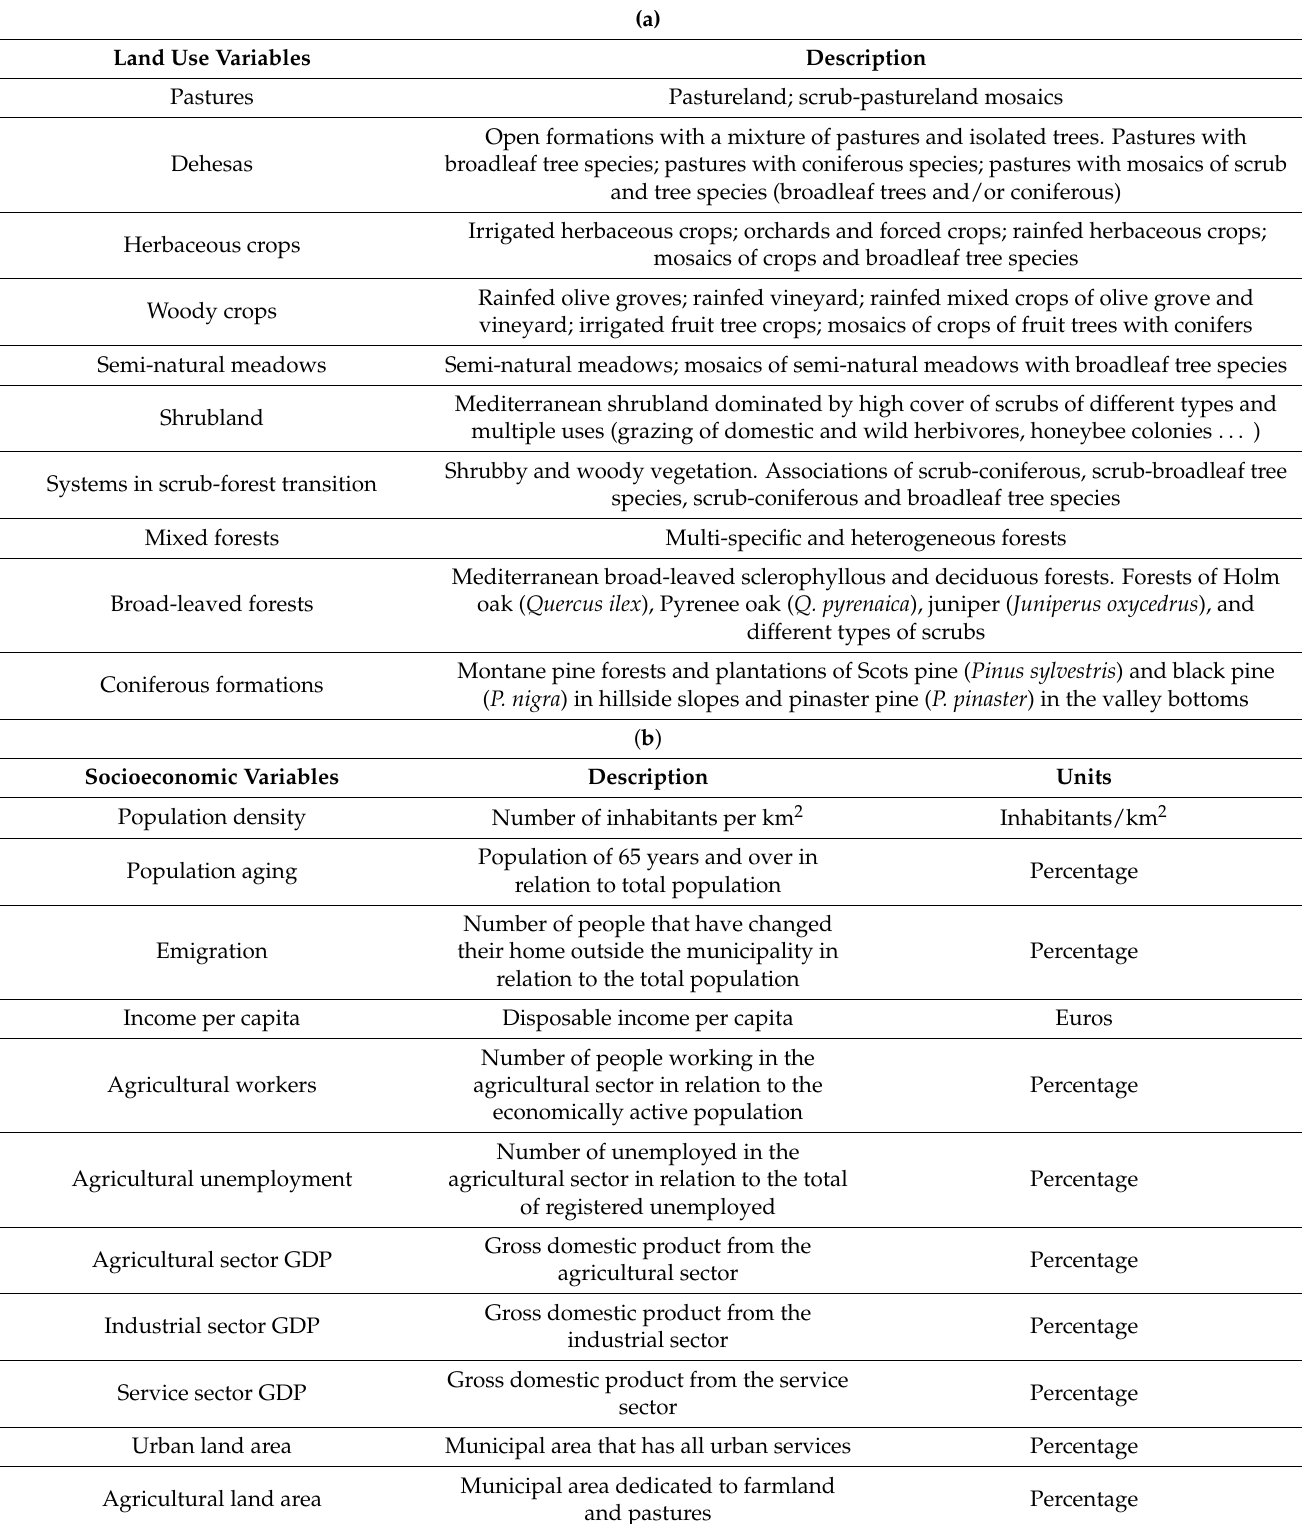
Table 1. Social-ecological descriptors recorded in each municipality of the study area. A brief description and units of measurement are indicated. (a) Land use–land cover descriptors considered as representative of high nature value farmlands of the studied cultural landscape. The unit of measurement was percentage area in relation to municipal area; (b) socioeconomic variables related to local population